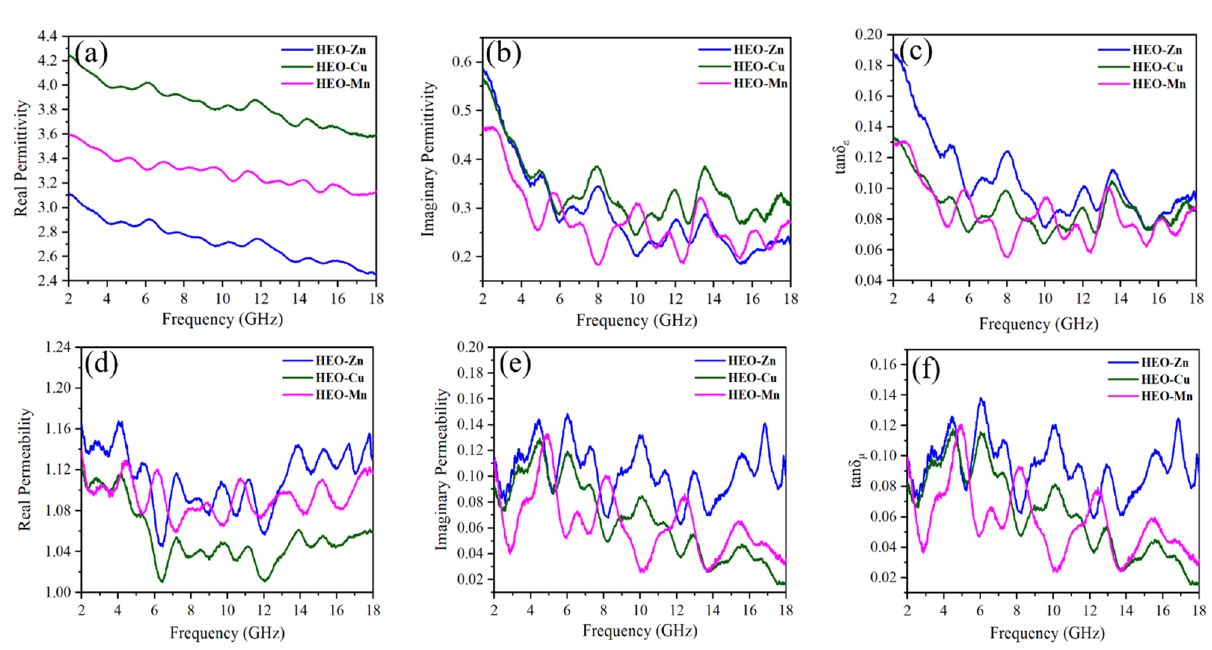
Figure 8. ( a ) The real part ( ε (cid:48) ), ( b ) imaginary part ( ε (cid:48)(cid:48) ) of permittivity, ( c ) dielectric loss tangent (tan δ ε ), and ( d ) the real part ( µ (cid:48) ), ( e ) imaginary part ( µ (cid:48)(cid:48) ) of permeability, ( f ) magnetic loss tangent (tan δ µ ) of HEO-Zn, HEO-Cu, and HEO-Mn